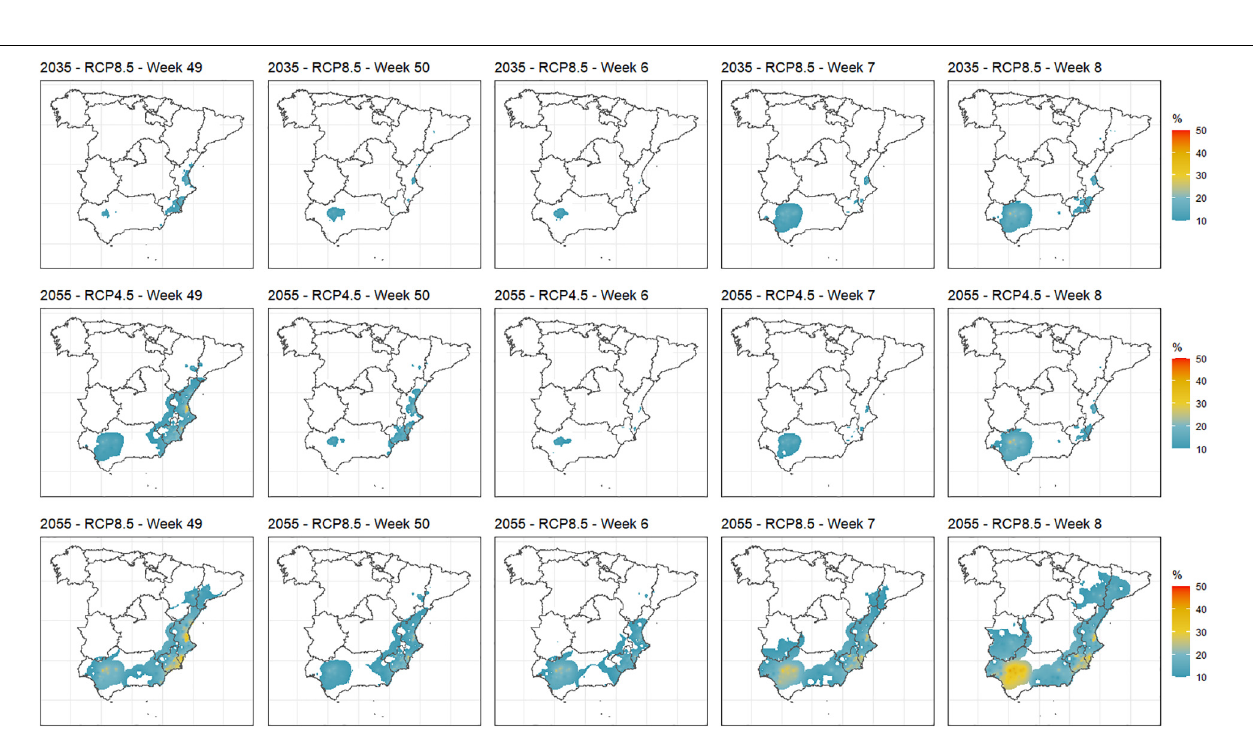
FIGURE 6 | Probability of abnormal heat events in the main stone production areas in Spain for weeks 49 (beginning of December) to 8 (end of February) in the 2035_RCP8.5, 2055_RCP4.5, and 2055_RCP8.5 scenarios.